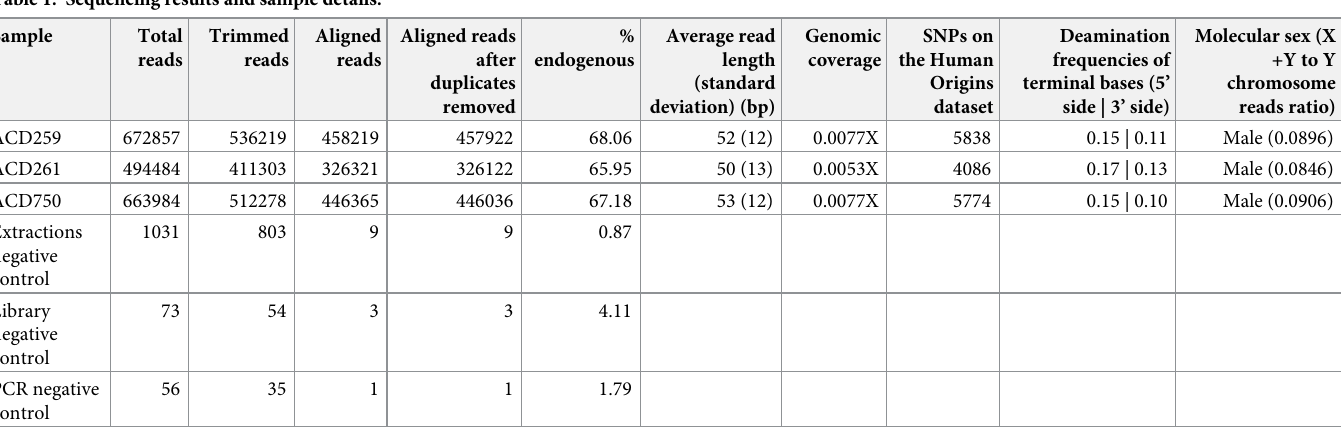
Table 1. Sequencing results and sample